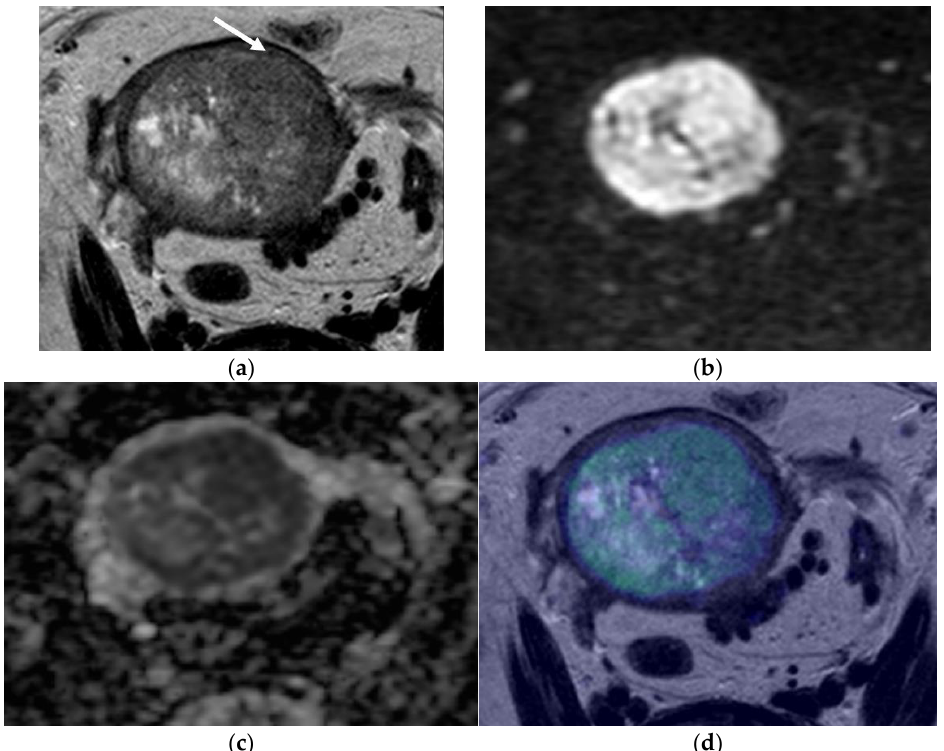
Figure 3. Pelvic MRI. Axial oblique sequences oriented to the corpus uteri long axis: ( a ) T2WI; ( b ) DWI (b1000); ( c ) ADC map; ( d ) fused T2WI-DWI image. In some cases, myometrial extension eval-